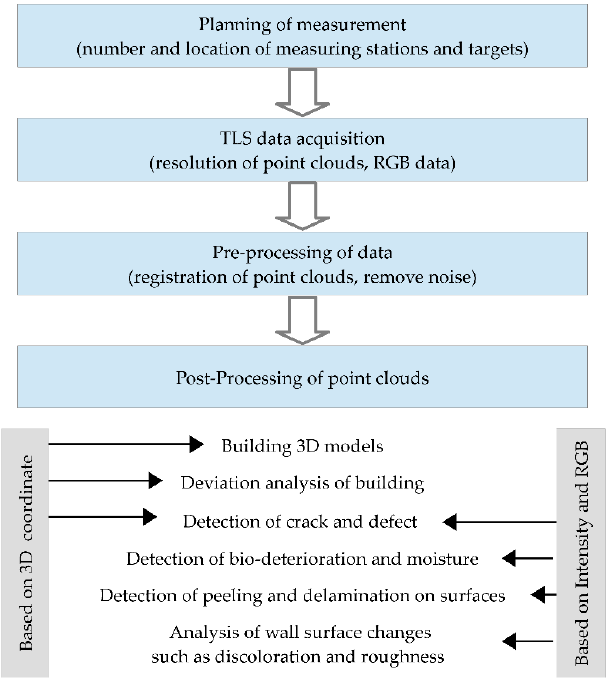
Figure 1. Methodology of documentation of brickwork heritage buildings.